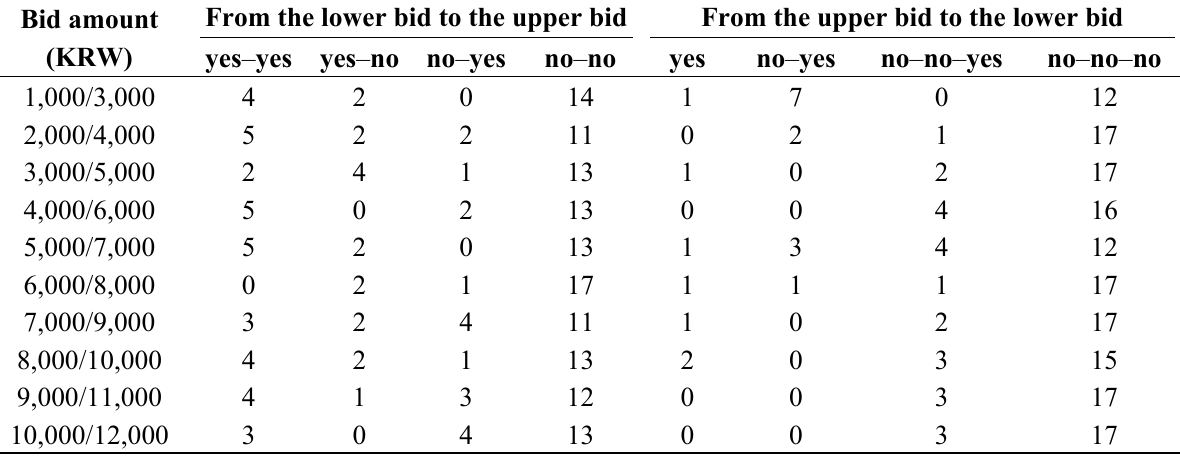
Table 1. Distribution of responses by the bid